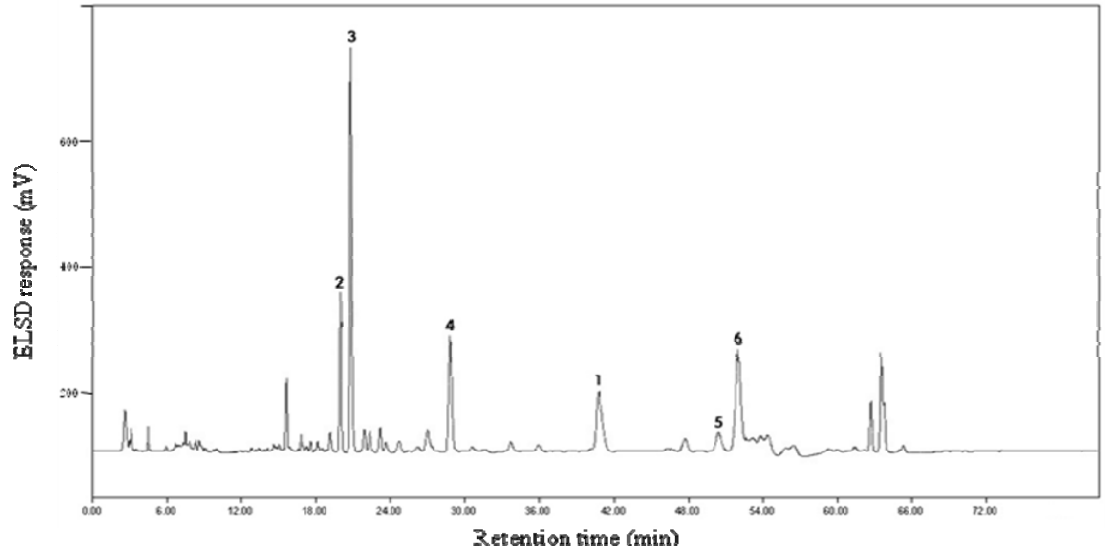
( 4 ), platycodin D 3 2